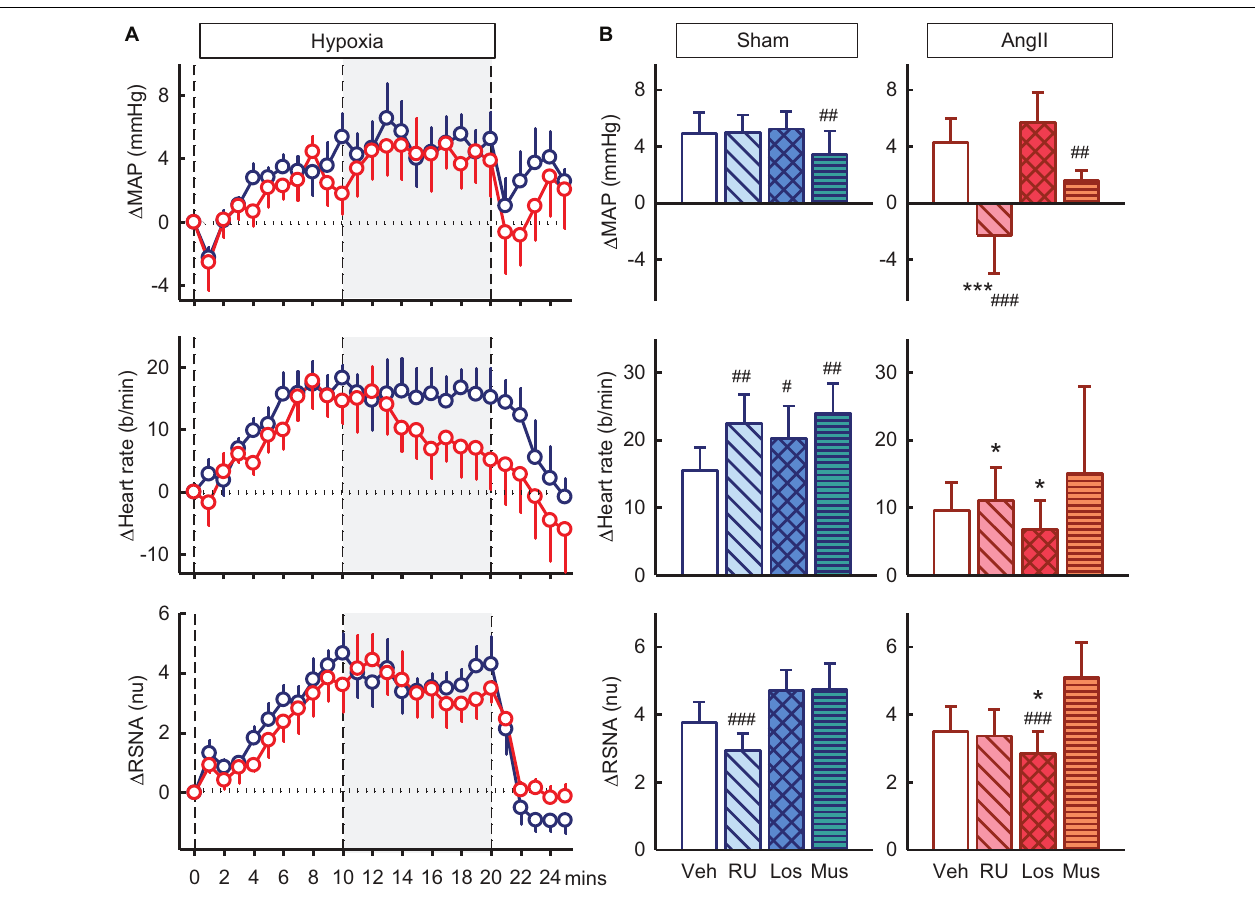
FIGURE 7 | Effects of antagonists and agonist on mean arterial pressure (MAP), heart rate and total renal sympathetic nerve activity (RSNA, normalized units) responses to hypoxia. (A) Line graphs show time course of changes from control in vehicle-treated sham (blue circles) and Ang II (red circles) rabbits to hypoxia (vertical dashed lines). (B) Bar graphs are average change from control in sham (left) and Ang II (right) rabbits, measured during period shown by gray shading, treated with vehicle (veh, white, n = 8–10), RU28318 (RU, n = 8–10, diagonal hatch), losartan (Los, n = 7, cross hatch), and muscimol (Mus, n = 5–6, horizontal hatch). Data are mean difference ± SED, * P < 0.05 and *** P < 0.001 for Ang II vs sham; # P < 0.05, ## P < 0.01, and ### P < 0.001 for antagonist or agonist vs